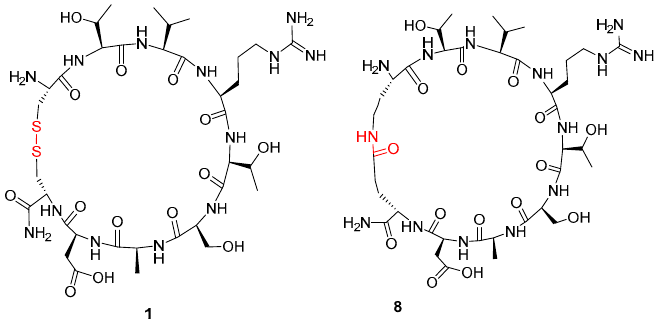
Figure 1. Chemical structures of peptide ligands 1 and 8 .